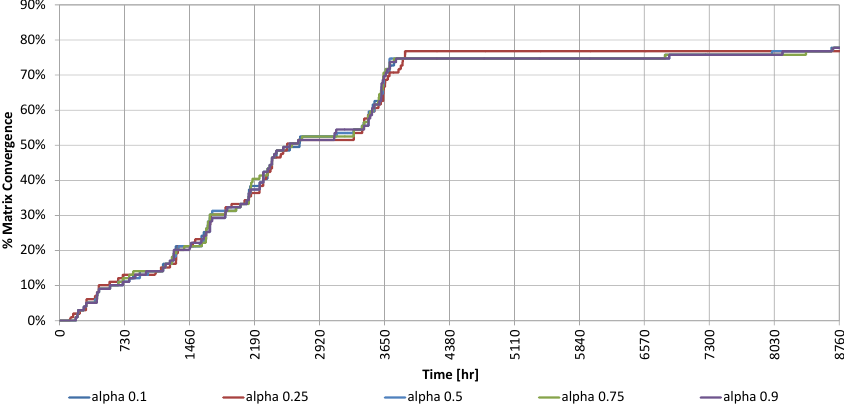
Figure 12. Convergence of the learning method using different learning factors ( 𝛼 = 0.1,0.25,0.5,0.75,0.9 ).